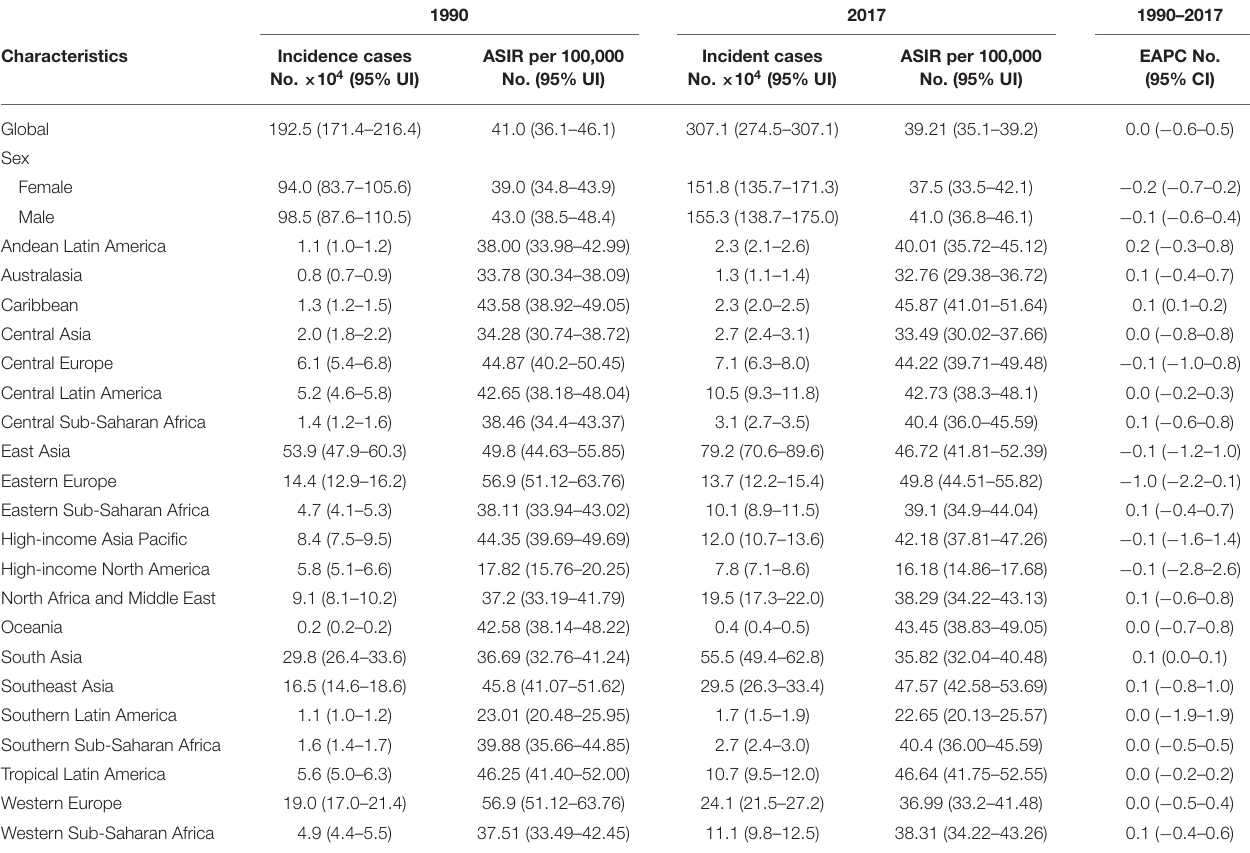
TABLE 1 | The incidence cases and age-standardized incidence rate of myocarditis between 1990 and 2017 and its temporal trends from 1990 to